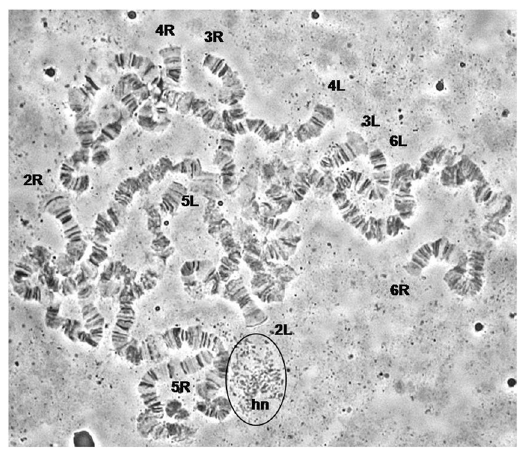
Figure 2. A polytene nucleus of Ceratitis fasciventris . The telomeres of the polytene elements are indicated. The heterochromatic network (hn) corresponding to the sex chromosomes is